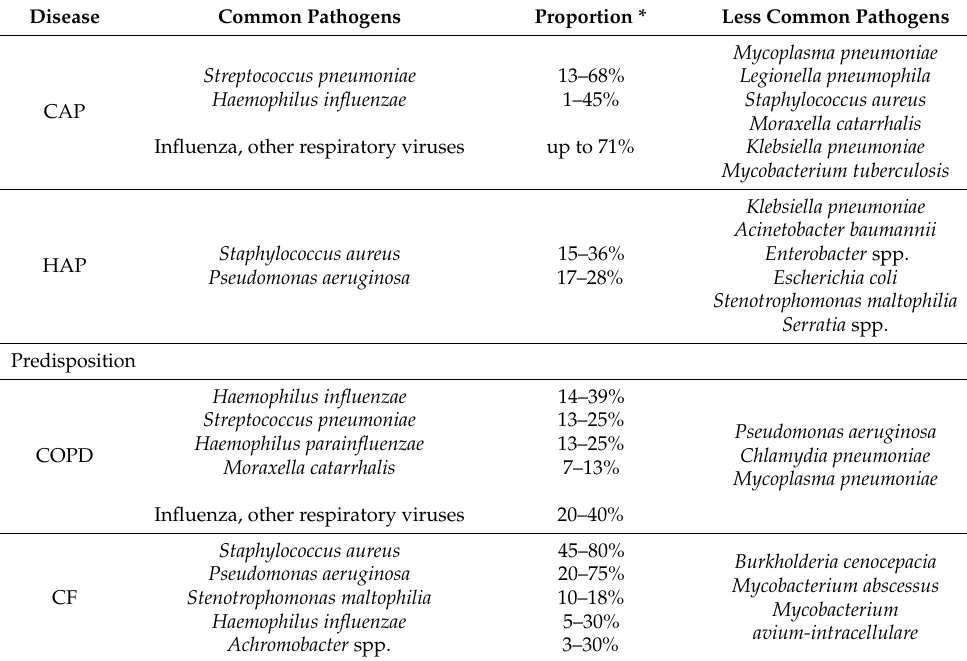
Table 1. Microbial etiology of lower respiratory tract infections in different conditions